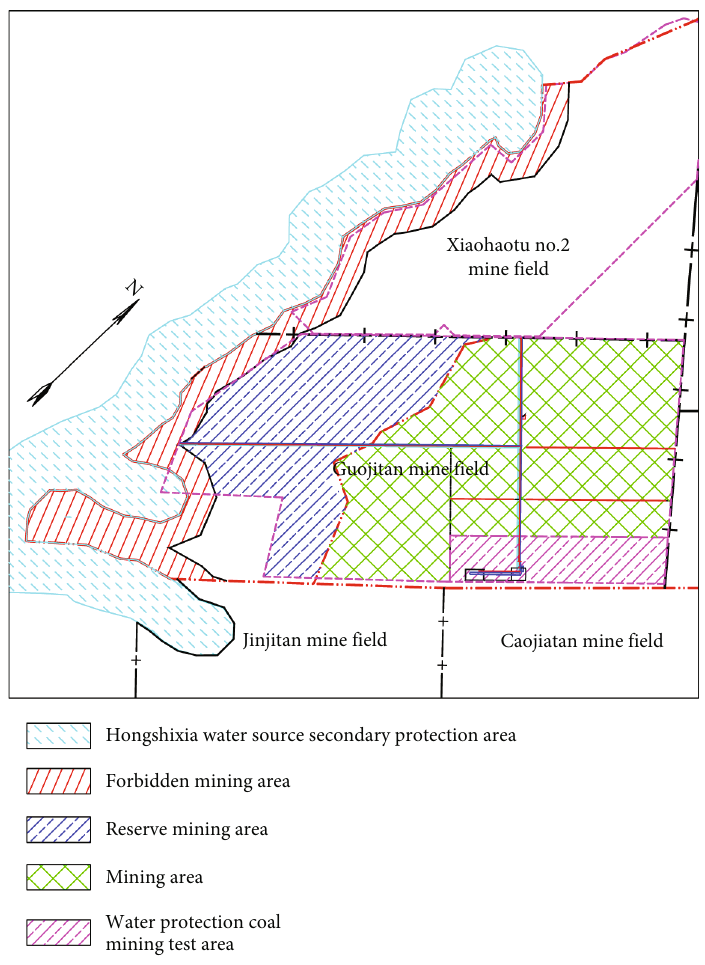
Figure 1: Relative location of mine fi eld and water preservation